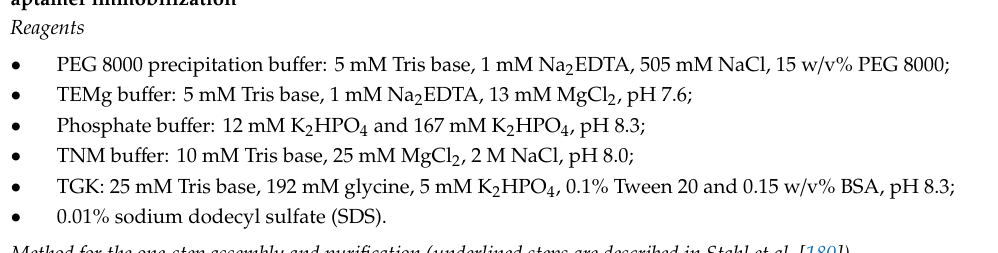
Protocol A10 by Daems et al. [141]: Immobilization of 24-helix DNA bundle as anchor platform for aptamer immobilization